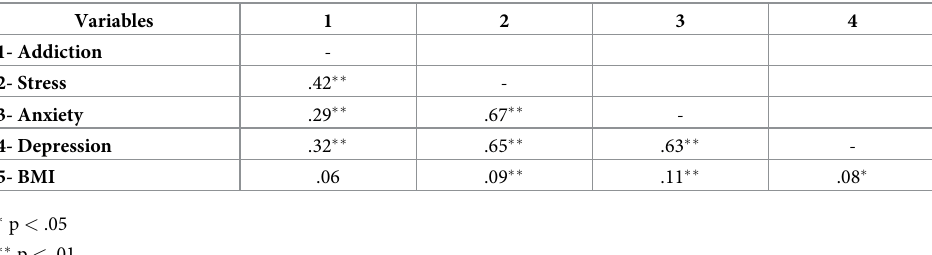
Table 4. Correlations between the variables (n =